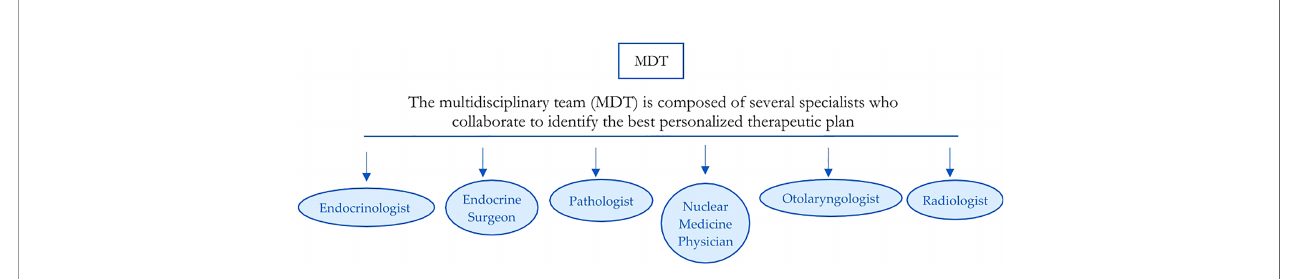
FIGURE 1 | Multidisciplinary